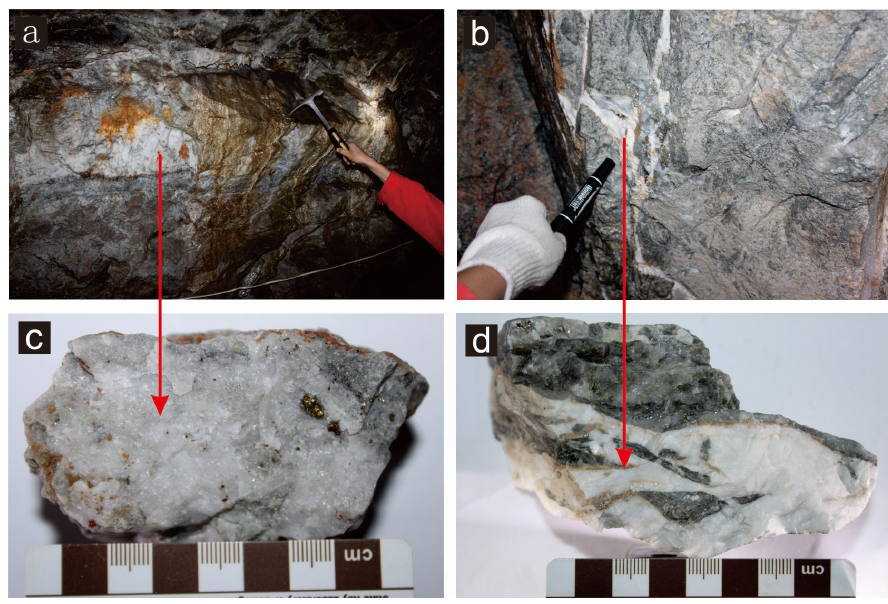
Figure 8. Photographs of the field view and ores shows the inclusion-hosted quartz ( a , c ) and calcite ( b , d